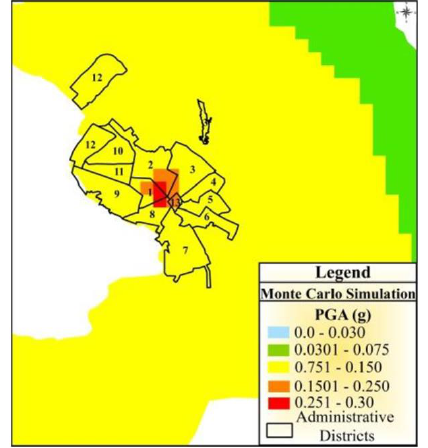
Figure 2. Zoning map of Seismic hazard